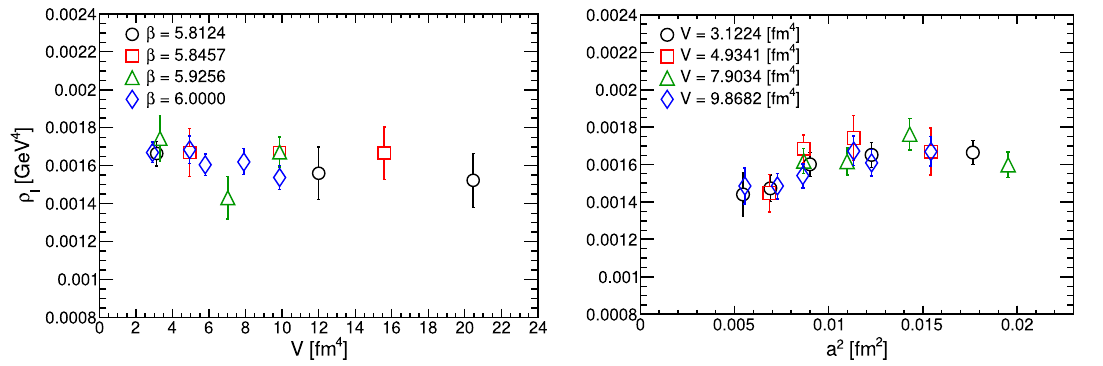
Fig. 6 The number density of the instanton and anti-instantons of the standard configurations. The left panel shows the numerical results of the parameter β = 5 . 8124 , 5 . 8457 , 5 . 9256 , and 6.0000, and the right